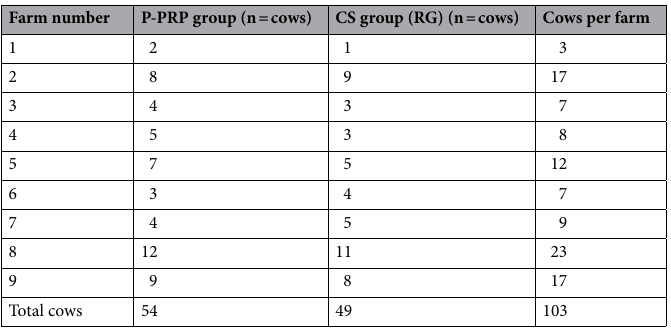
Farm number P-PRP group (n = cows) CS group (RG) (n = cows) Cows per